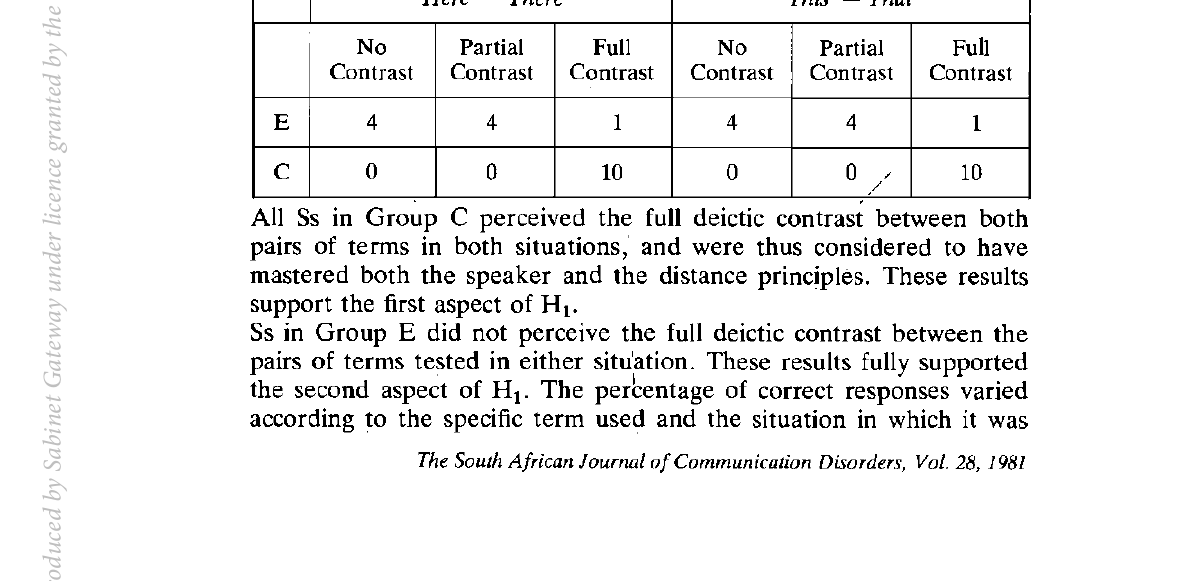
TABLE IV: Number of Ss that fell into each category for each pair of terms (Task 1) Here —